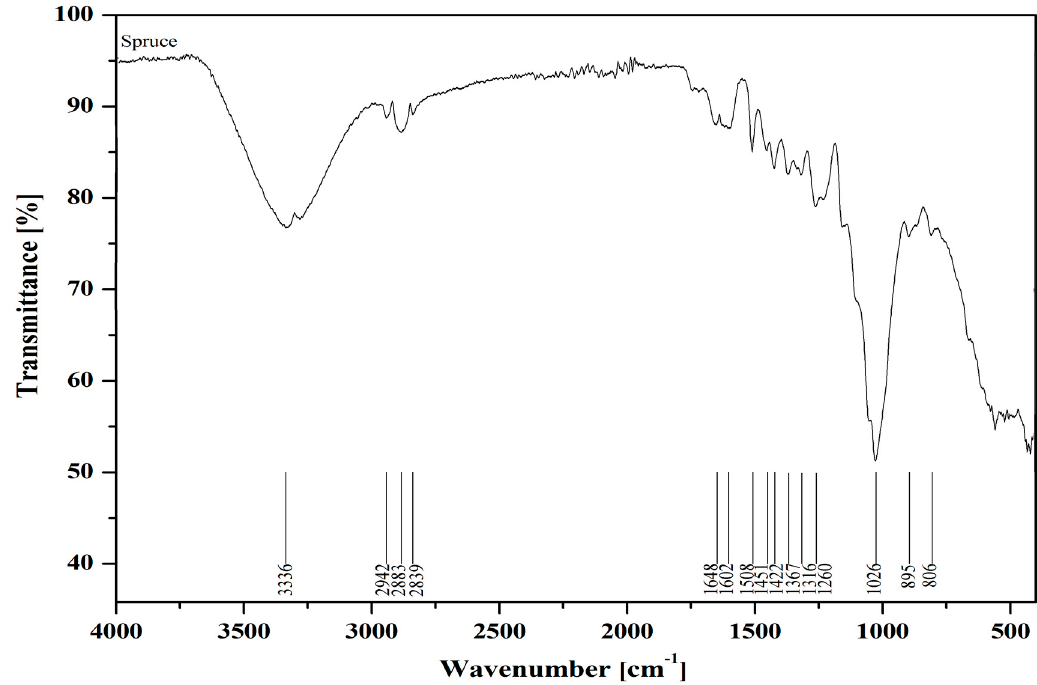
Figure 1. Infrared spectra of spruce sawdust.